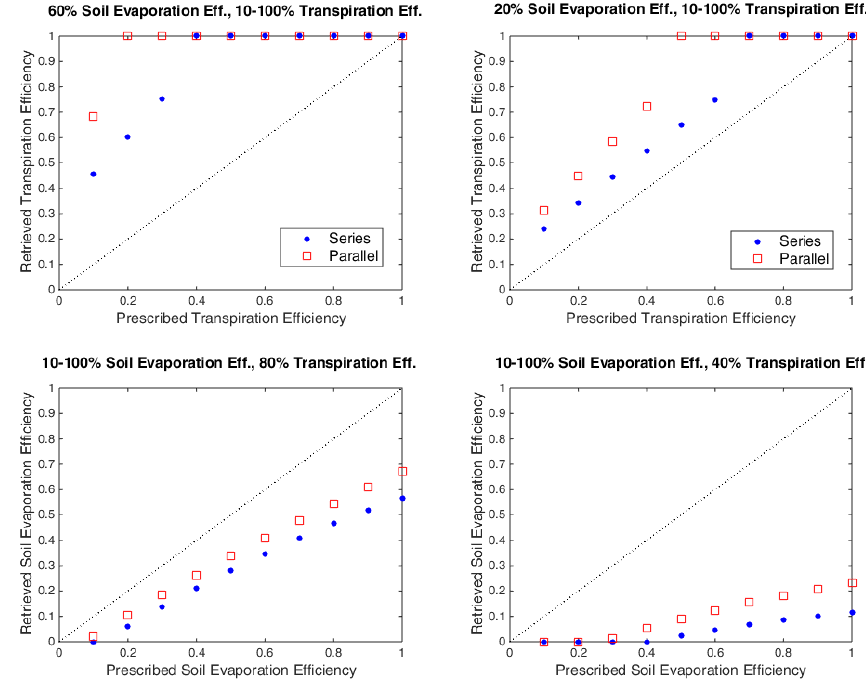
Figure 4. Retrieval test for component evapotranspiration ( β s , β v ) efficiencies when using T rad values as input to SPARSE for given combi- nations of prescribed β s and β v